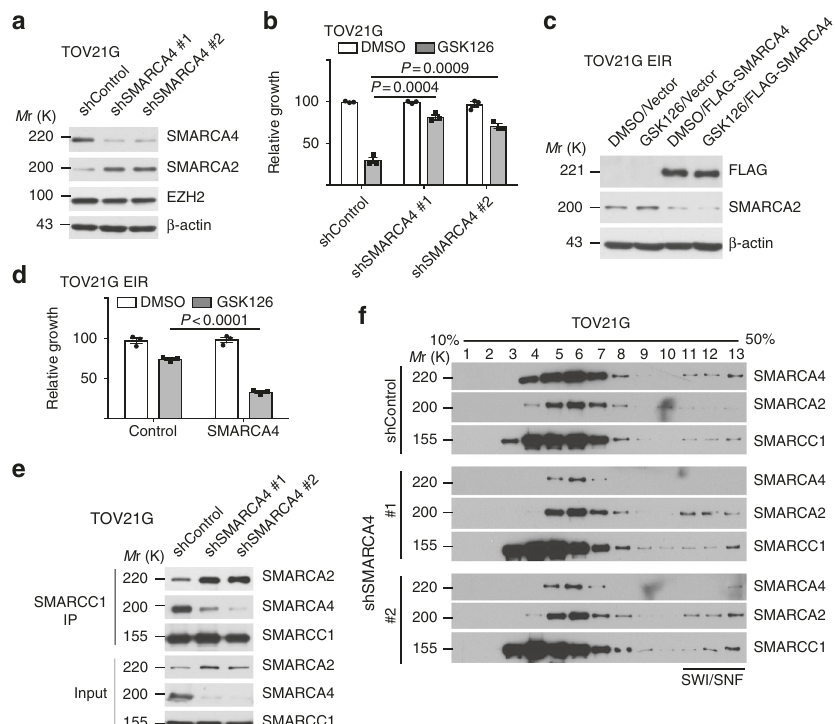
Fig. 2 Downregulation of SMARCA4 drives the observed switch to SMARC2 in the SWI/SNF complex. a , b SMARC4 knockdown in parental ARID1A - mutated TOV21G cells increases SMARCA2 levels ( a ) and desensitizes parental cells to GSK126 treatment (5 μ M) ( b ). c , d Ectopic SMARCA4 expression in resistant cells decreases SMARCA2 levels ( c ) and resensitizes resistant cells to GSK126 (10 μ M) ( d ). e Co-immunoprecipitation analysis using an antibody to core subunit SMARCC1 shows the switch of the catalytic subunit from SMARCA4 to SMARCA2 in TOV21G cells with or without SMARCA4 knockdown. f Sucrose sedimentation (10 – 50%) assay of SWI/SNF complex from TOV21G cells with or without SMARCA4 knockdown. Data